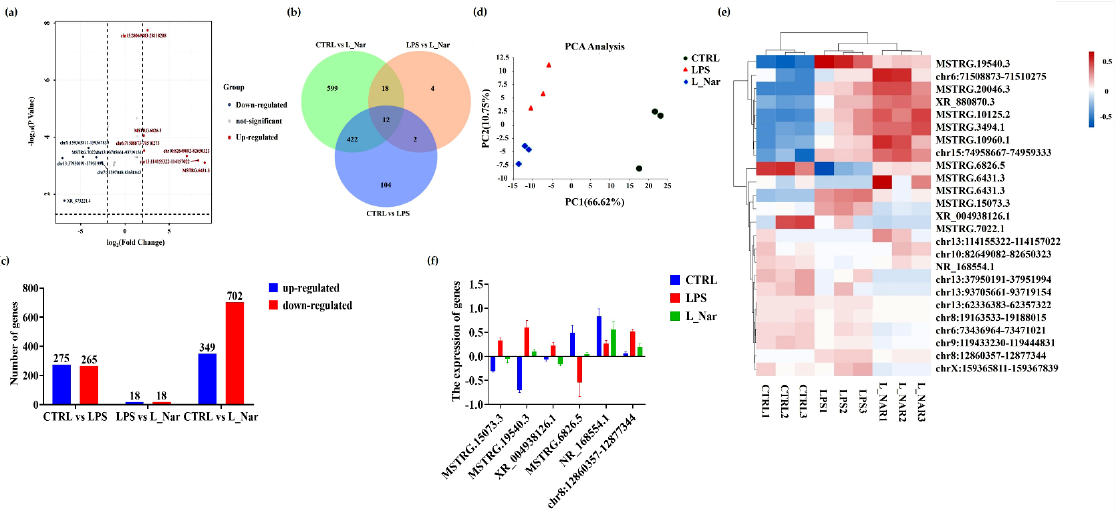
Figure 3. Effects of naringenin on the liver transcriptome of liver tissue of mice: ( a ) volcanic map analysis of DEGs; ( b ) Venn diagrams representing the DEGs specific or common among CTRL, LPS, and L_Nar groups, respectively; ( c ) number of significantly upregulated and downregulated genes in comparisons of the CTRL and LPS groups, LPS and L_Nar groups and CTRL and L_Nar groups; ( d ) principal component analysis; ( e ) hierarchical clustering of the liver samples and the expression pattern of all DEGs based on the transcriptomic profiles; ( f ) expression tendencies of differentially expressed long noncoding RNA between LPS and Nar. Data are expressed as mean ± SEM ( n = 3). * p < 0.05, ** p < 0.01 versus CTRL group. DElncRNA: differential expression lncRNA.